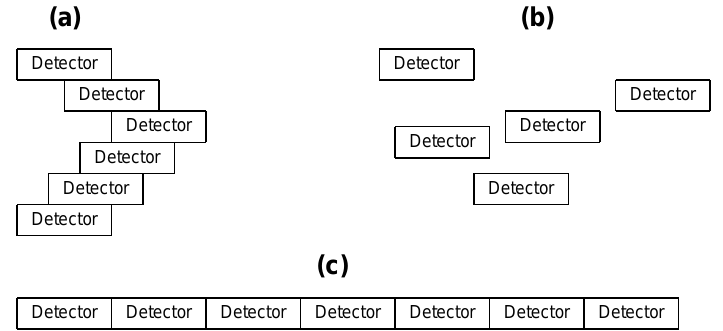
Figure 8. (a) PFx sensor with detectors deployed vertically with a specific horizontal displacement. (b) PFx sparse detector with random detector displacement. (c) PFx sparse detector with only horizontal